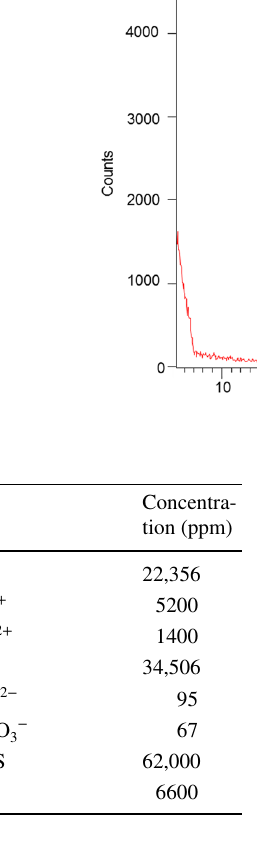
Fig. 1 XRD analysis of the used